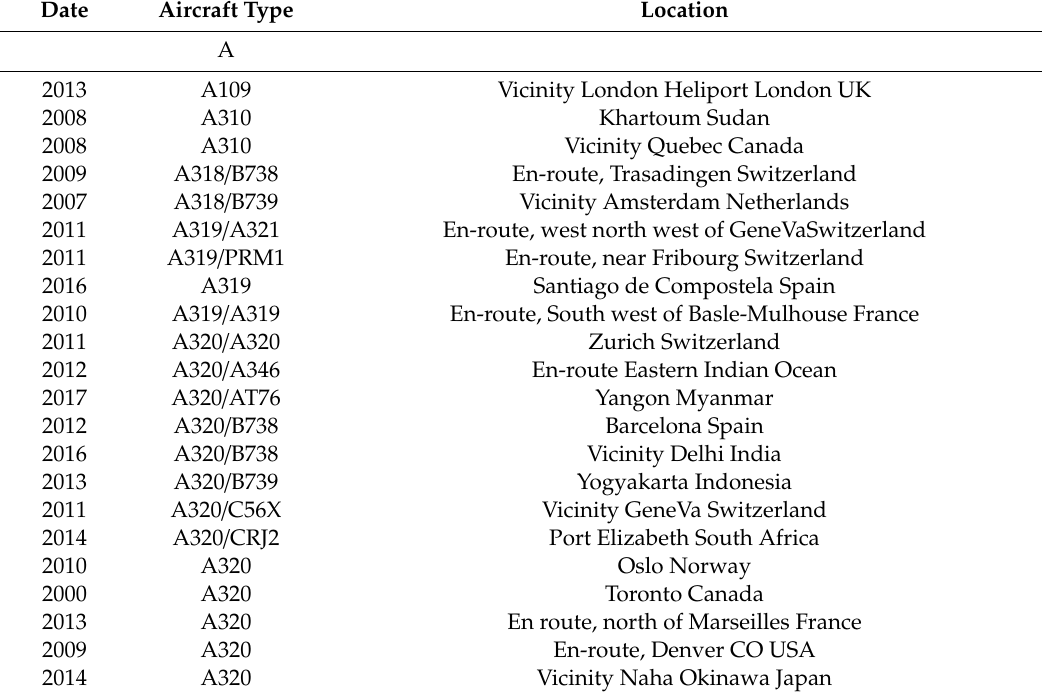
Table A1. Brief information on air accidents /